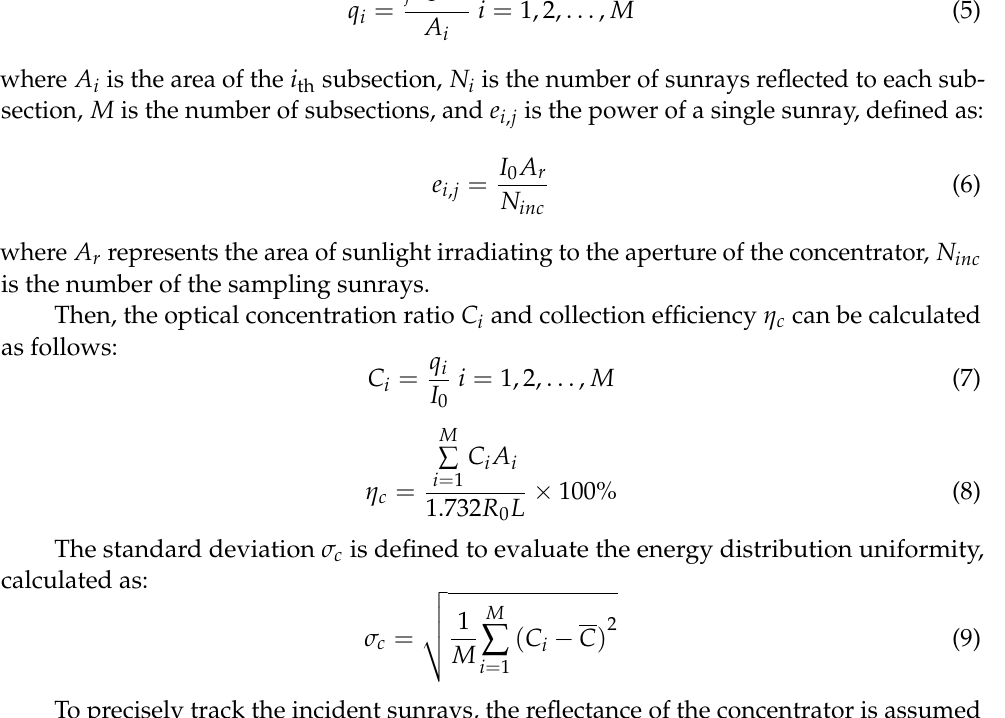
Figure 5. Illustration of the ray-trace technique.